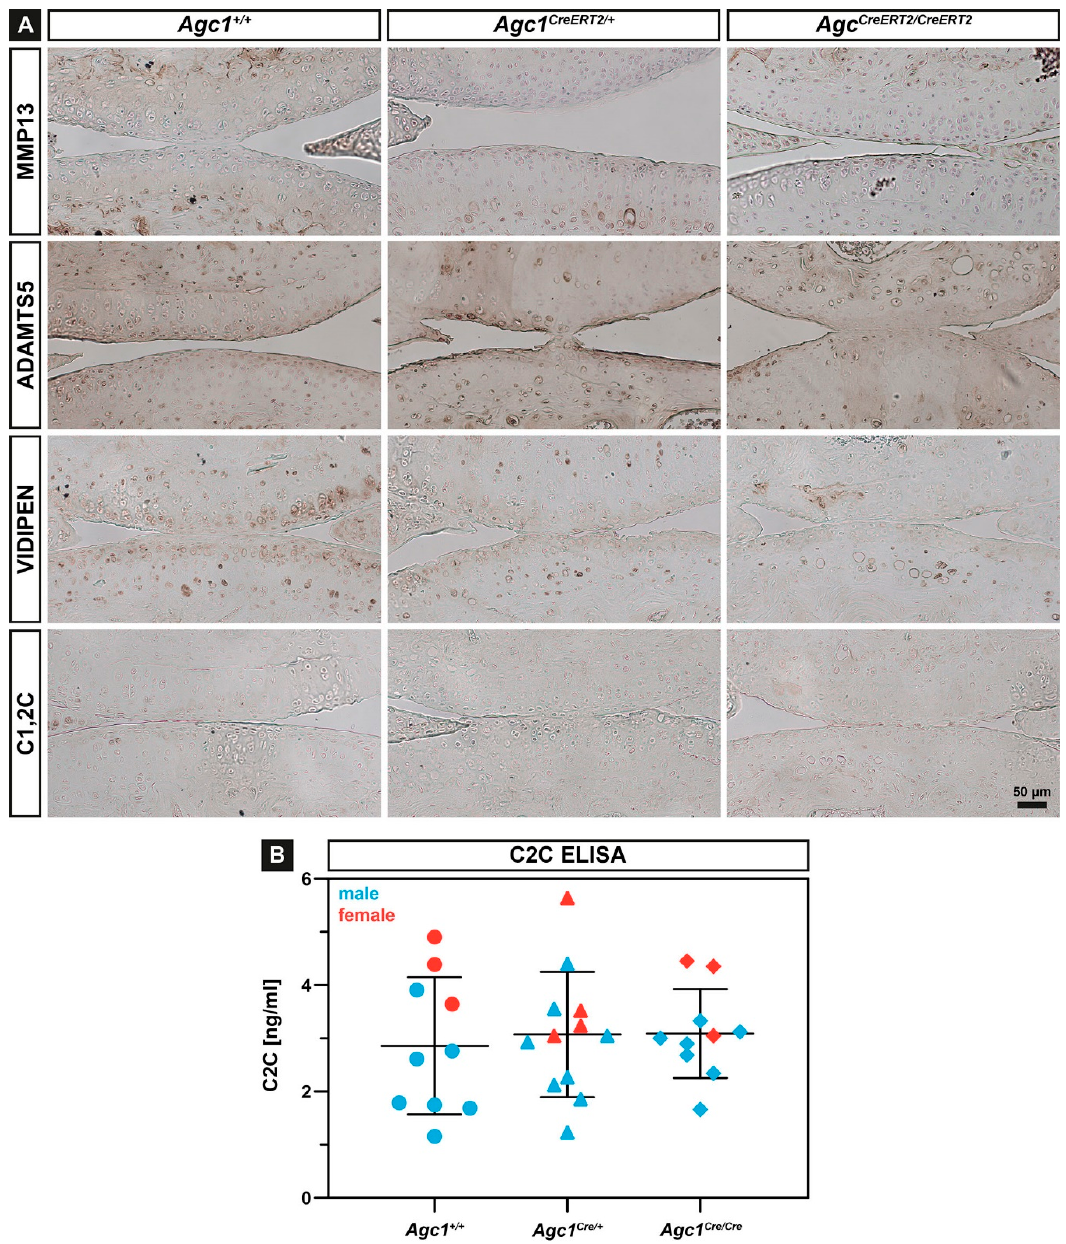
Figure 5. Analysis of cartilage catabolism. ( A ) representative immunostaining of MMP-13, ADAMTS-5, VIDIPEN and C1,2C of sections from the articular cartilage at 12 months of age in Agc1 +/+ , Agc1 CreERT2/+ and Agc1 CreERT2/CreERT2 , mice. n = 5 per genotype; ( B ) C2C ELISA assay in urine of 12-month-old animals. Bars represent mean ± SD. n = Agc1 +/+ : 6(m)/4(f); Agc1 Cre/+ : 8(m)/4(f); Agc1 Cre/Cre : 7(m)/3(f).